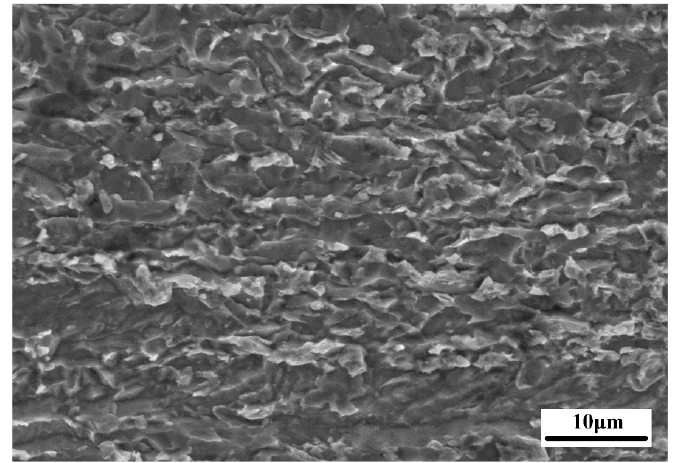
Figure 1. Microstructure of the X100 pipeline steel base metal. Table 1. Chemical composition and carbon equivalent (CE) of X100 pipeline steel (wt%).